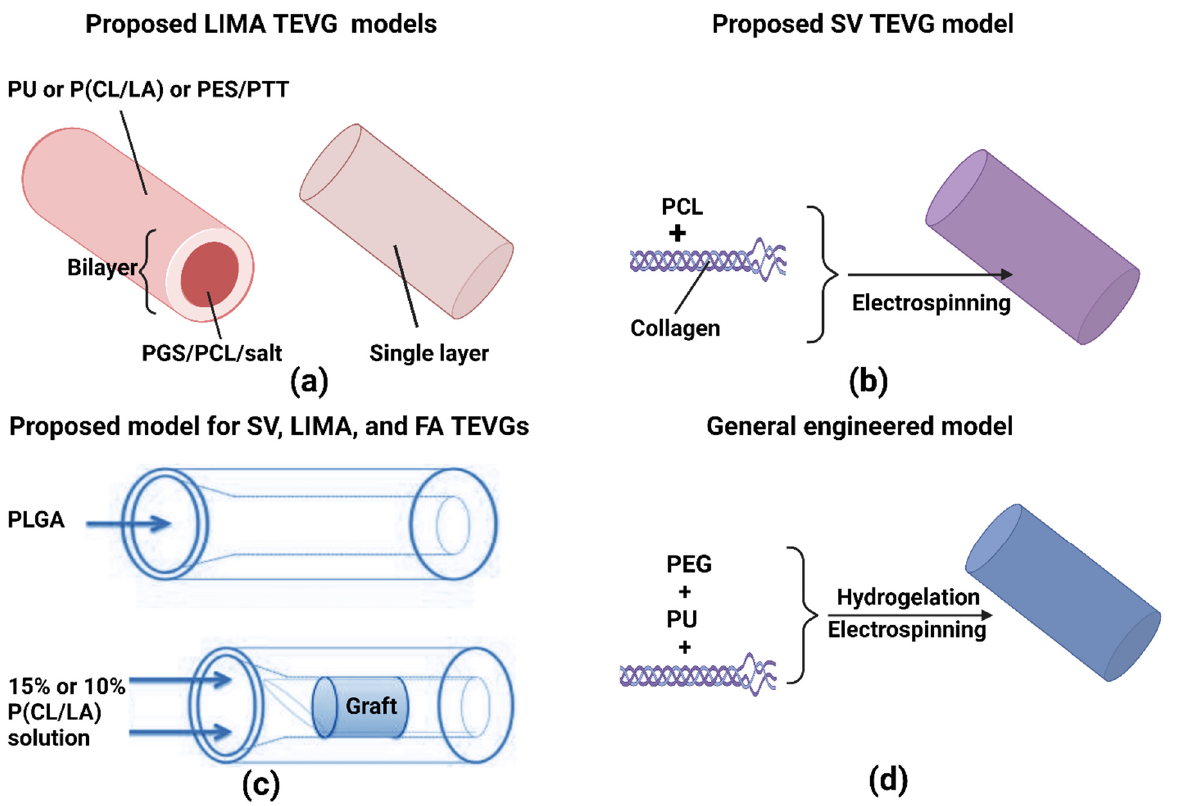
Figure 3. Proposed models for polymeric TEVGs. ( a ) Proposed LIMA TECG models, ( b ) proposed SV TEVG model ( c ) proposed model for SV, LIMA, and FA TEVGs, and ( d ) general engineered model .